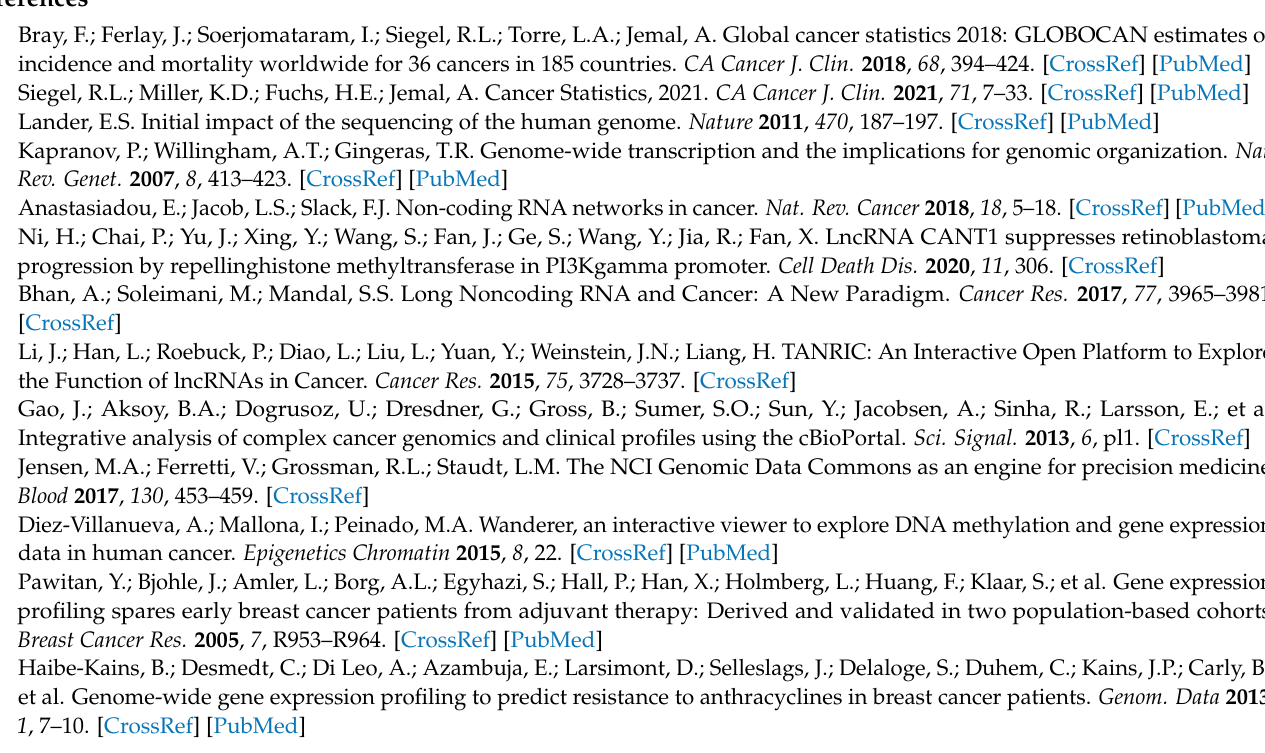
Table S4: Correlations between ZNF582-AS1 expression and DNA methylation in the ZNF582-AS1 promoter 13 CpG sites; Table S5: Predicted miRNA targets on the ZNF582-AS1 transcripts; Table S6: Predicted transcription factors for ZNF582-AS1